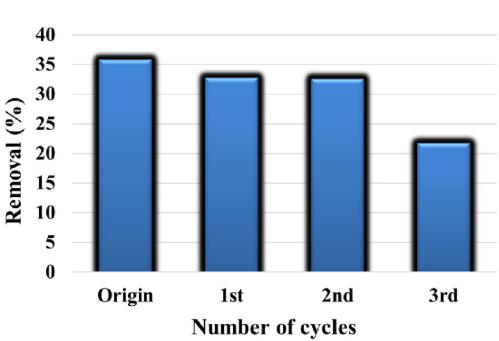
Figure 13. Removal % of DB86 dye by regenerated